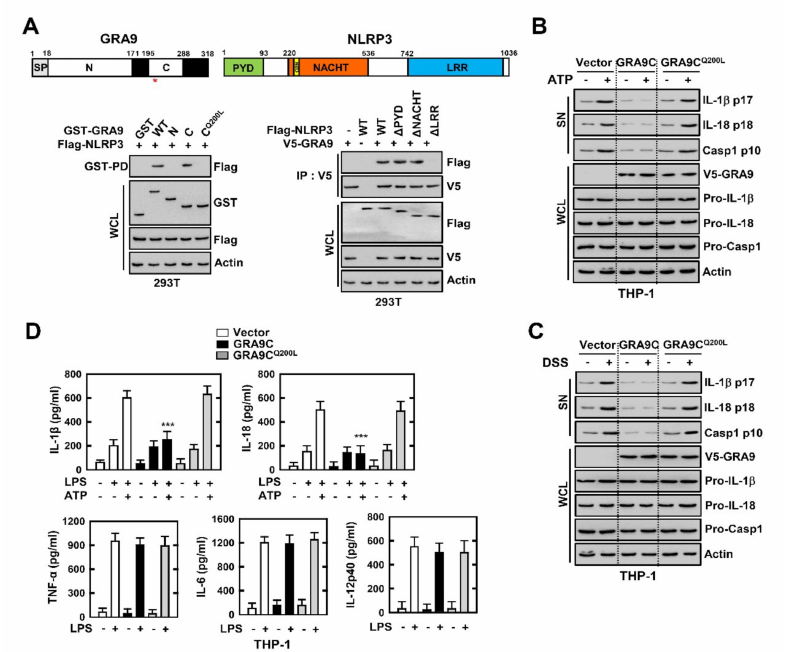
Figure 3. C-terminal of GRA9 attenuates the induction of NLRP3 inflammasome through binding with NLRP3. ( A ) Binding mapping. Schematic diagrams of the structures of GRA9 and NLRP3 (upper). At 48 h after transfection with mammalian glutathione S-transferase (GST) or GST-GRA9 and truncated mutant constructs together with Flag-NLRP3 or Flag-NLRP3 constructs together with V5-GRA, 293T cells were used for GST pull down or immunoprecipitated by α V5, followed by IB with α Flag, or α V5. Cell lysates (WCLs) were used for IB with α GST, α V5, α Flag, α V5, or α Actin. ( B , C ) Vector, GRA9C or GRA9C Q200L expressing THP-1 cells primed with LPS (100 ng mL − 1 ) for 4 h and stimulated with ATP (5 mM) or DSS (3%) for 1 h or 18 h, followed by IB in supernatant (SN) with α IL-1 β p17, α IL-18 p18 or α Casp1 p10 and WCL with α Pro-IL-1 β , α Pro-IL-18, α Pro-Casp1, or α Actin. ( D ) Level of cytokines is analyzed by ELISA for IL-1 β , IL-18, TNF- α , IL-6, and IL-12p40. The data are representative of four independent experiments with similar results ( A – D ). ( D ) Significant di ff erences (*** p < 0.001) compared with rVector-expressing THP-1 cells. Full-length images of the blots presented in the Figure